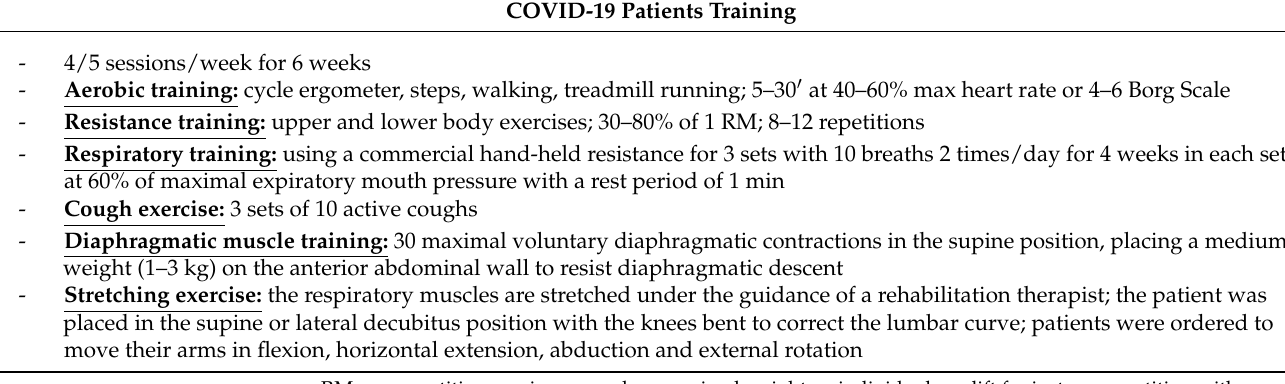
Table 1. COVID-19 training [15–21] based on the few available data.